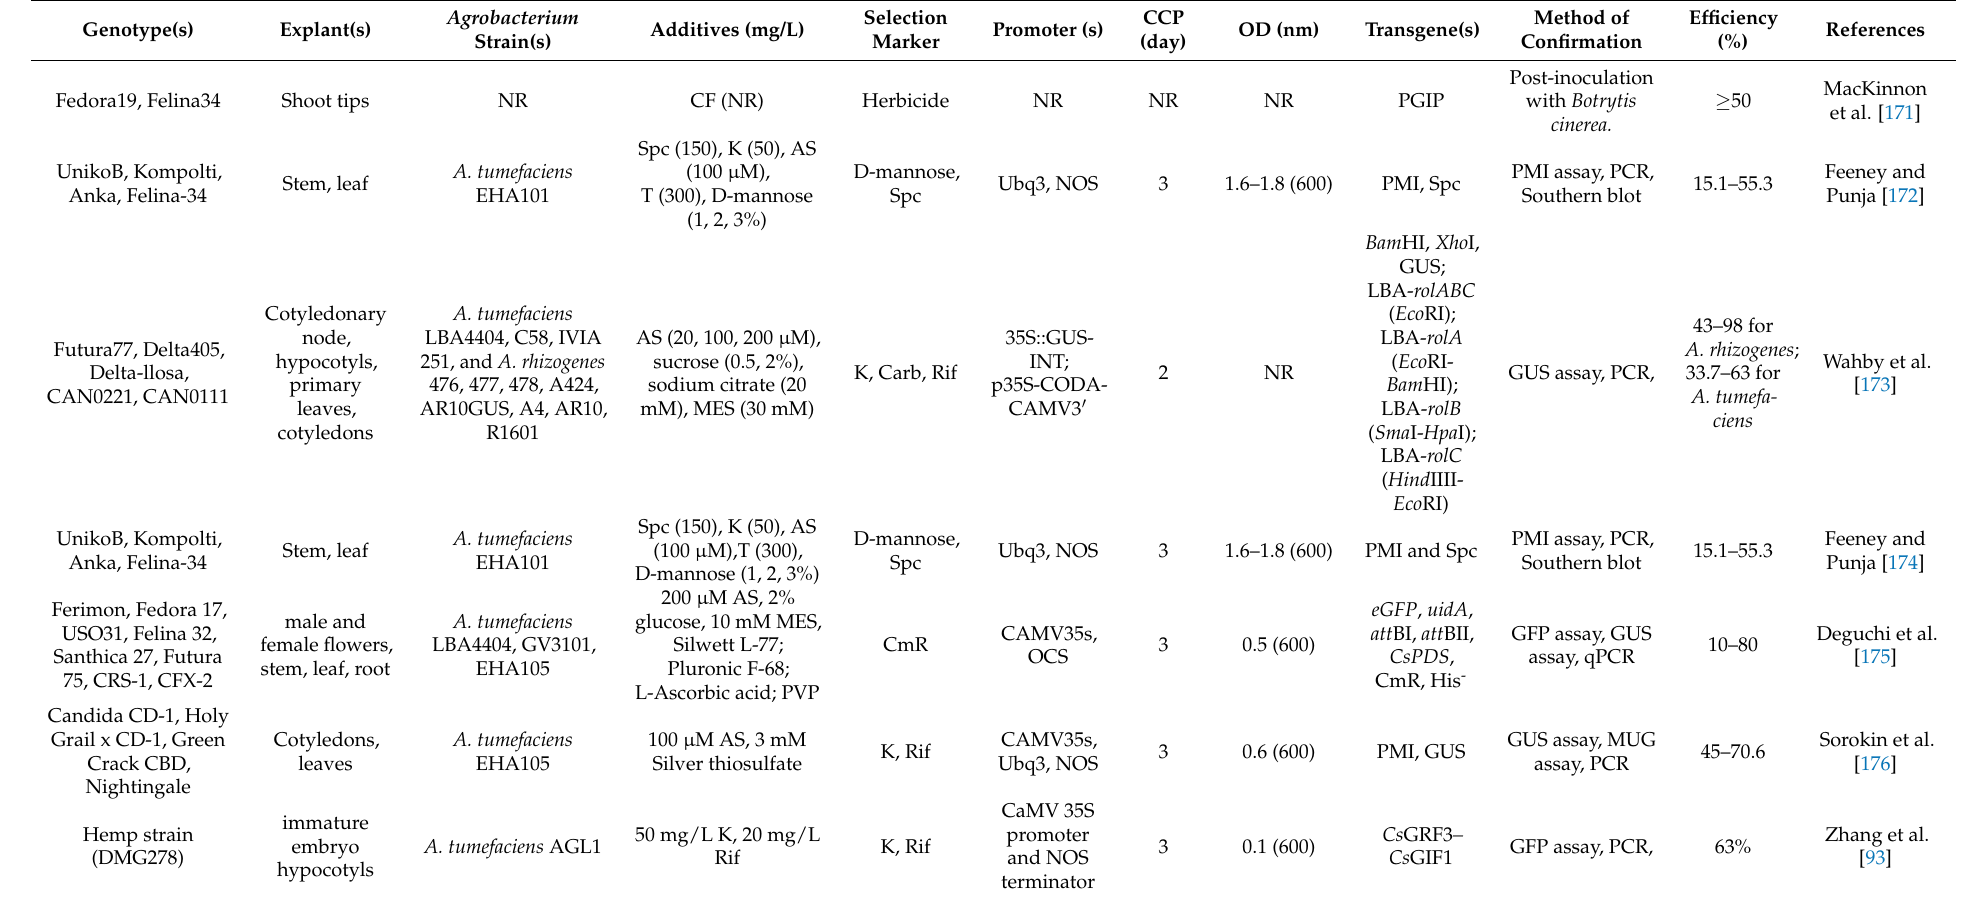
Table 5. Agrobacterium -mediated gene transformation studies in